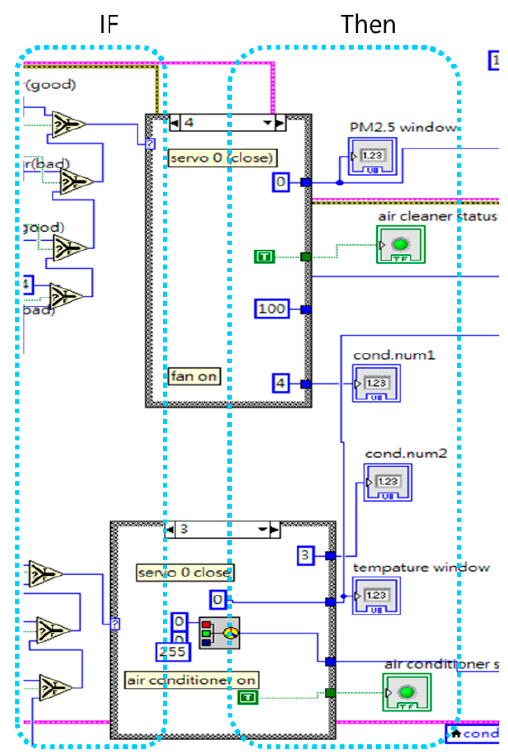
Figure 16. Rule-based case structure.